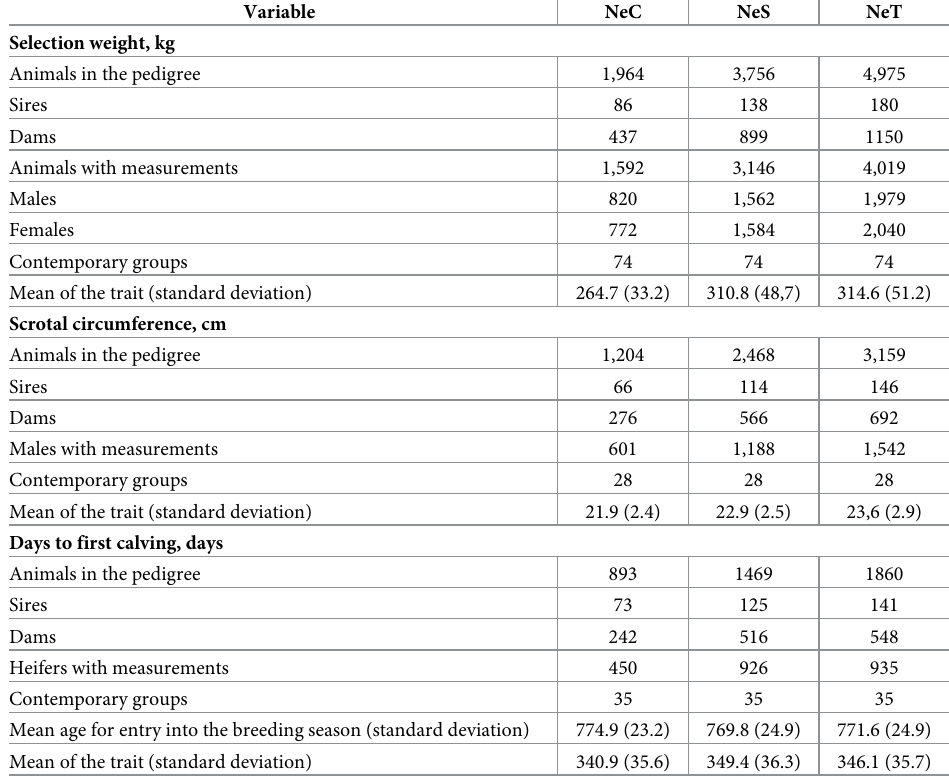
Table 1. Descriptive data of the control (NeC), selection (NeS), and traditional (NeT) lines of Nellore cattle. Variable NeC NeS